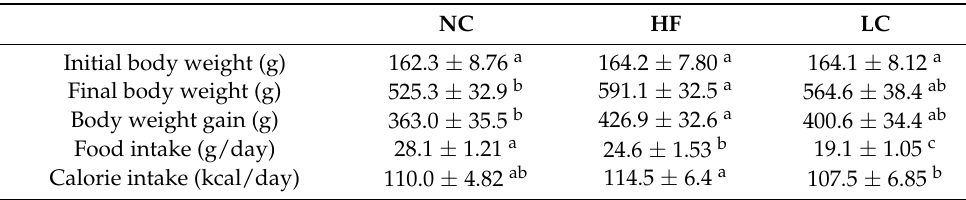
Figure 1. The plasma levels of β -hydroxybutyrate in rats fed with the different experimental diets for 11 weeks. Results are expressed as mean ± SD for each group ( n = 7). Mean values with different letters are significantly different, p < 0.05. Table 2. The body weight and food intake in rats fed with the different experimental diets for 11